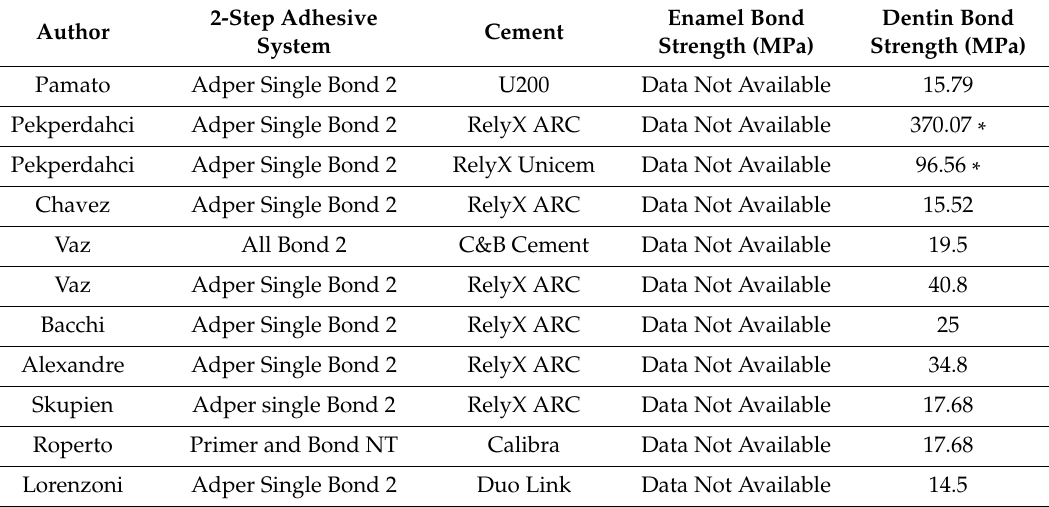
Table 3. Bond strength of etch and rinse 2-step systems (MPa).